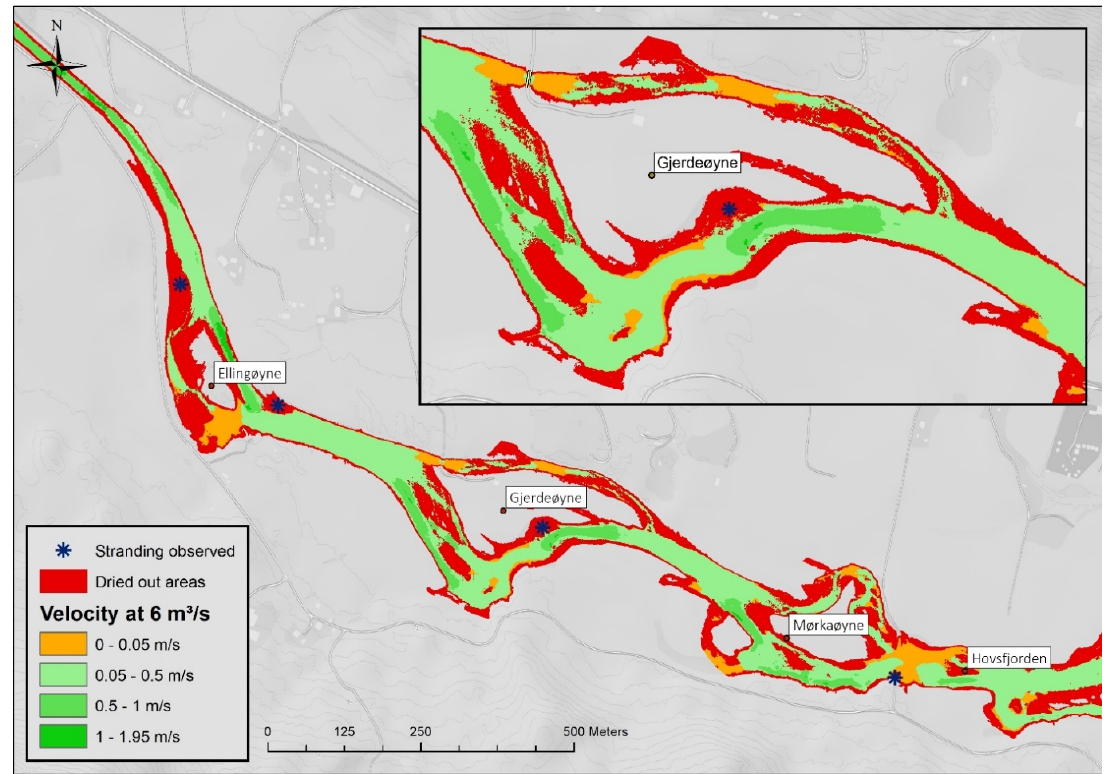
Figure 7. Variation of wetted area downstream Hol 1 hydropower plant: in green the velocity of wetted at residual flow, in red the area dried passing from 51 m 3 /s to residual flow (6 m 3 /s). In contrast with Ellingøyne, where the dry areas appear mostly for discharge below 21 m 3 /s, dry areas in Gjerdeøyne start to appear at discharges below 66 m 3 /s until residual flow, meaning that this transition is not so